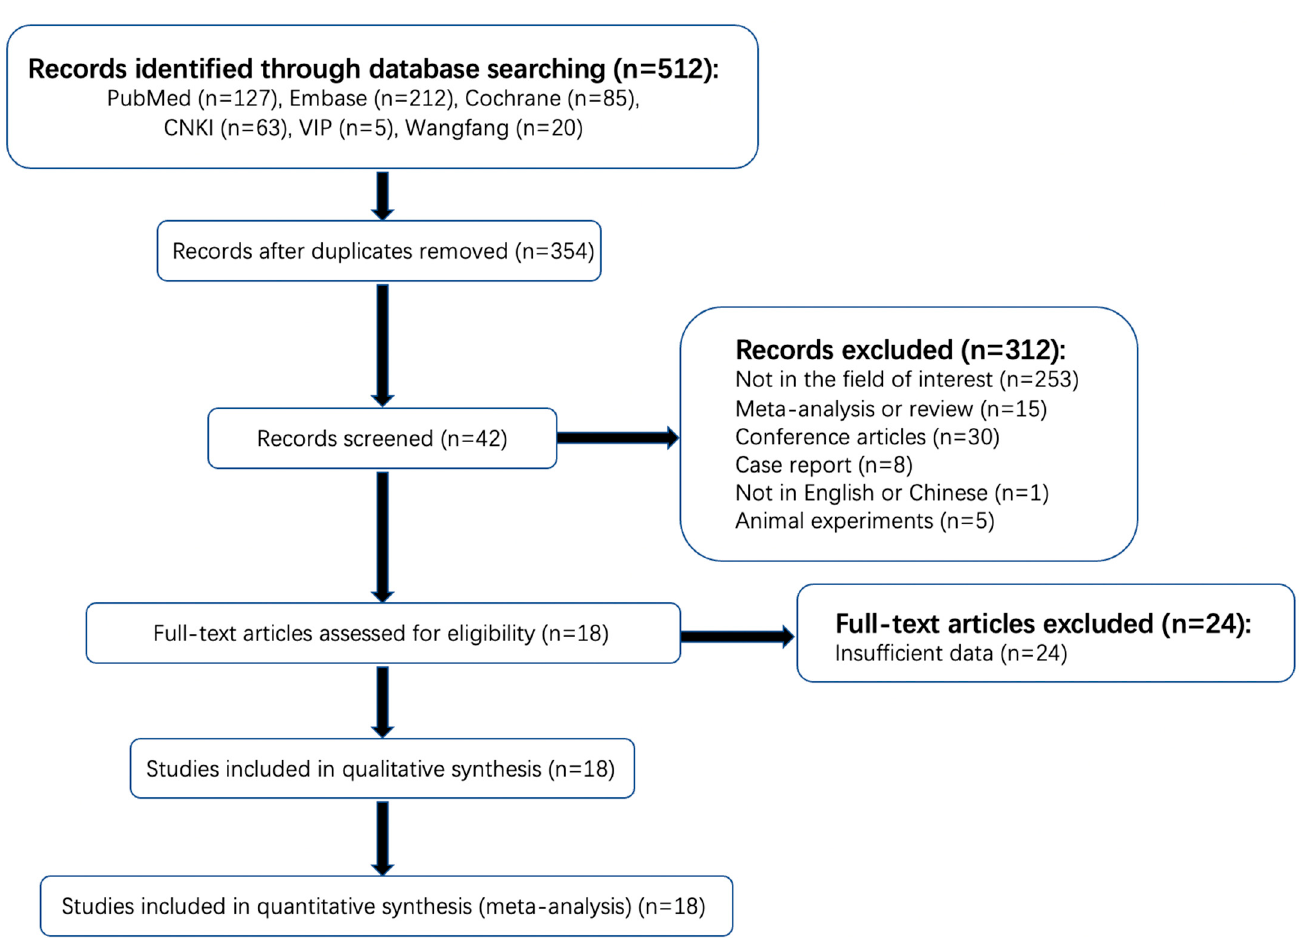
Figure 1. Flowchart of search strategy and selection of reports.